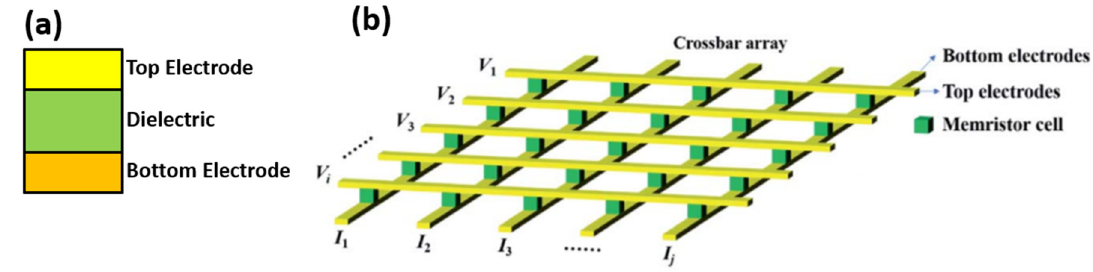
Figure 1: Schematic of ( a ) a unit cell of RRAM and ( b ) an array of crossbar structure with voltages ( V i ) and current ( I j ) applied and measured, respectively, on top and bottom electrodes [ 4 ] .